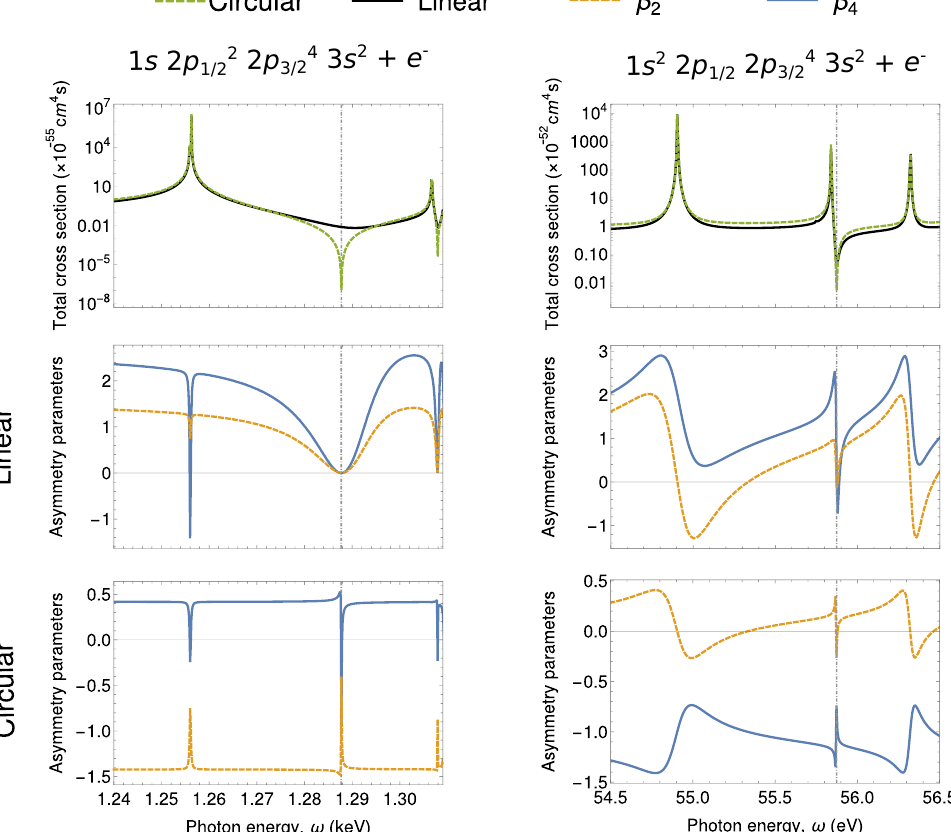
Figure 2. Two-photon ionization of 1 s ( left ) and 2 p 1 / 2 ( right ) electrons of neutral magnesium. Local minima in the total ionization cross section (first row) can be clearly seen. These so called nonlinear Cooper minima arise due to a zero contribution from the otherwise dominant ionization channel. The minima are even more strongly imprinted in the photoelectron angular distributions both for ionization of magnesium by linearly (second row) as well as circularly (last row) polarized